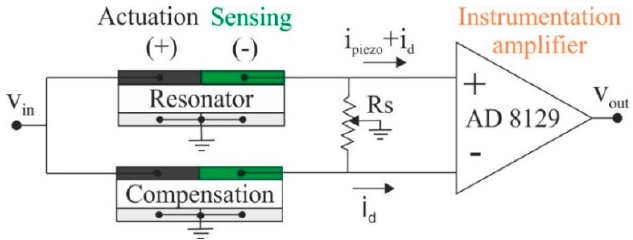
Figure 2. Schematic of interface circuit to measure the 05-mode response by cancelling the parasitic capacitance.